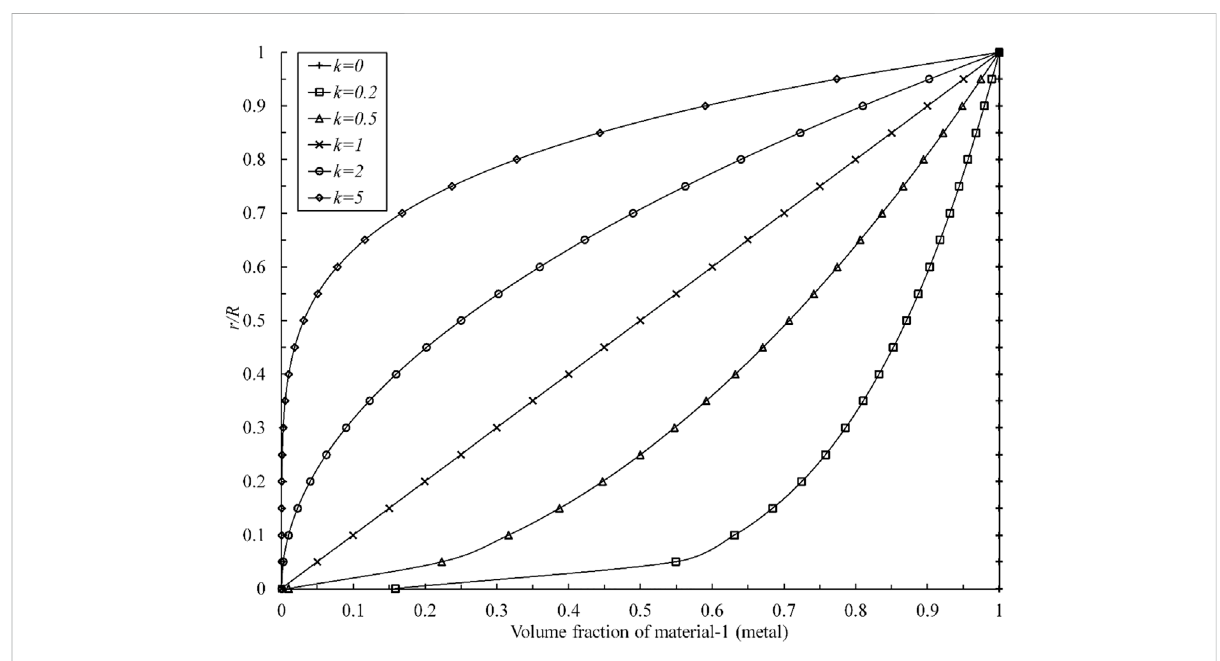
FIGURE 2 The volume fraction of material-1 (metal) with respect to r/R for various k